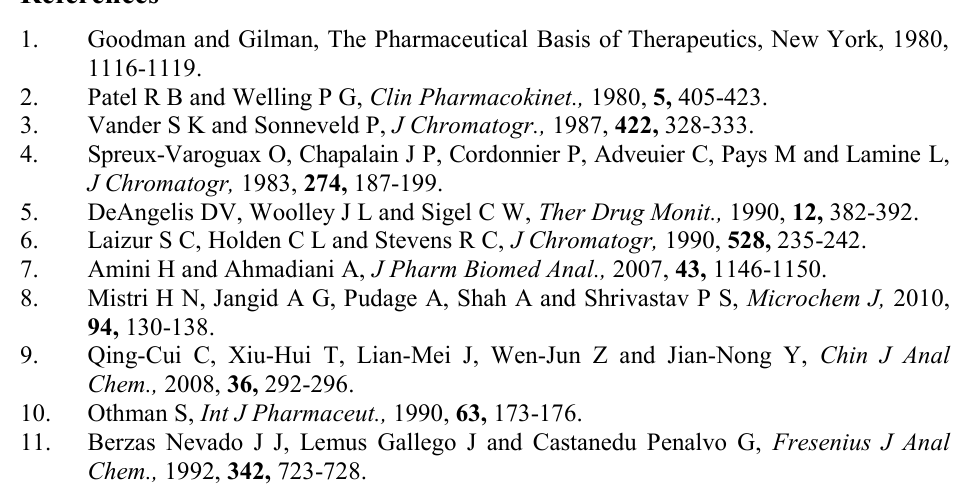
Table 6. Results of the replicate measurements for determination of SMX and TMP in some biological fluids, expressed as   for N=6 measurements and 571.2 NDtSX ..  Sample Added, µmol L -1 Found, µmol L -1 Recovery, % SMX TMP SMX TMP SMX TMP 10 Plasma